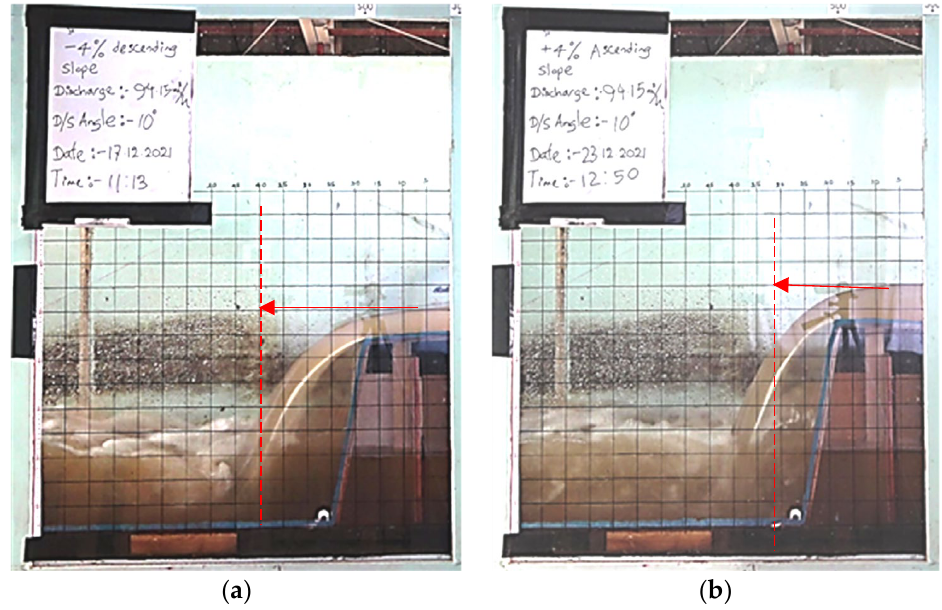
Figure 9. Change of the position of the hydraulic jump concerning the type of the nappe flow and downstream slope: ( a ) − 4% descending crest slope (EM-N DC ) for 10° downstream slope , ( b ) +4% ascending crest slope (EM-N AC ) for 10° downstream slope.